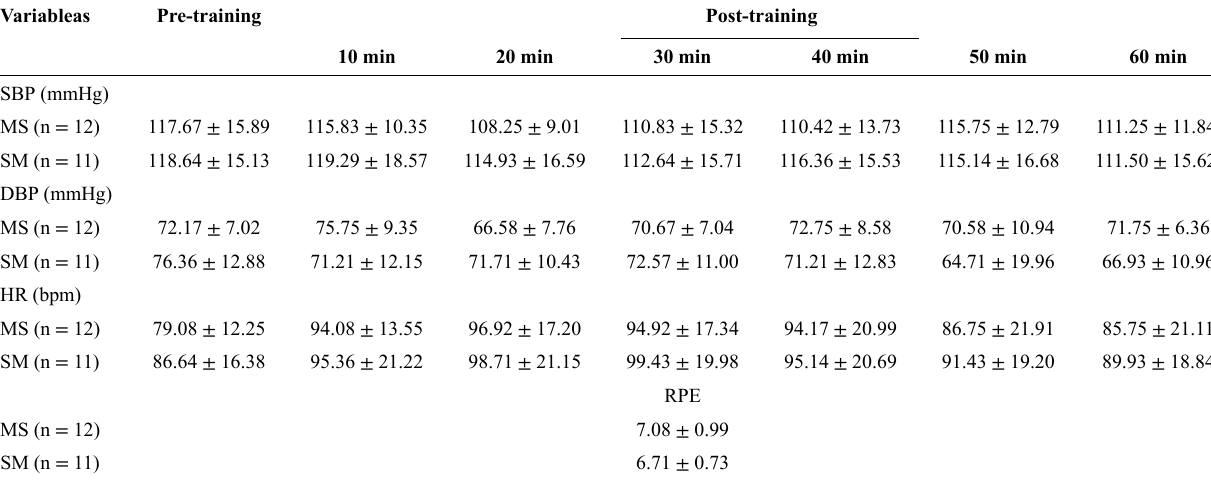
Table 2 - Behavior of systolic and diastolic blood pressure, heart rate, and rating of perceived exertion according to different resistance exercise orders in middle-aged and older women. Variableas Pre-training